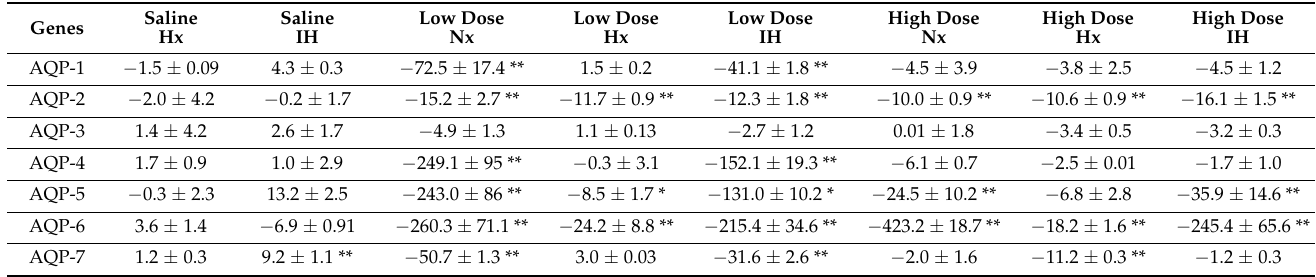
reactivities correspond to Figures 4, 6, 8 and 9, respectively. The number of tubes formed corresponds to Figure 10. Data were analyzed using two-way ANOVA with Dunnett’s post hoc test. * p < 0.05, ** p < 0.01 vs. saline; # p < 0.05, ## p < 0.01